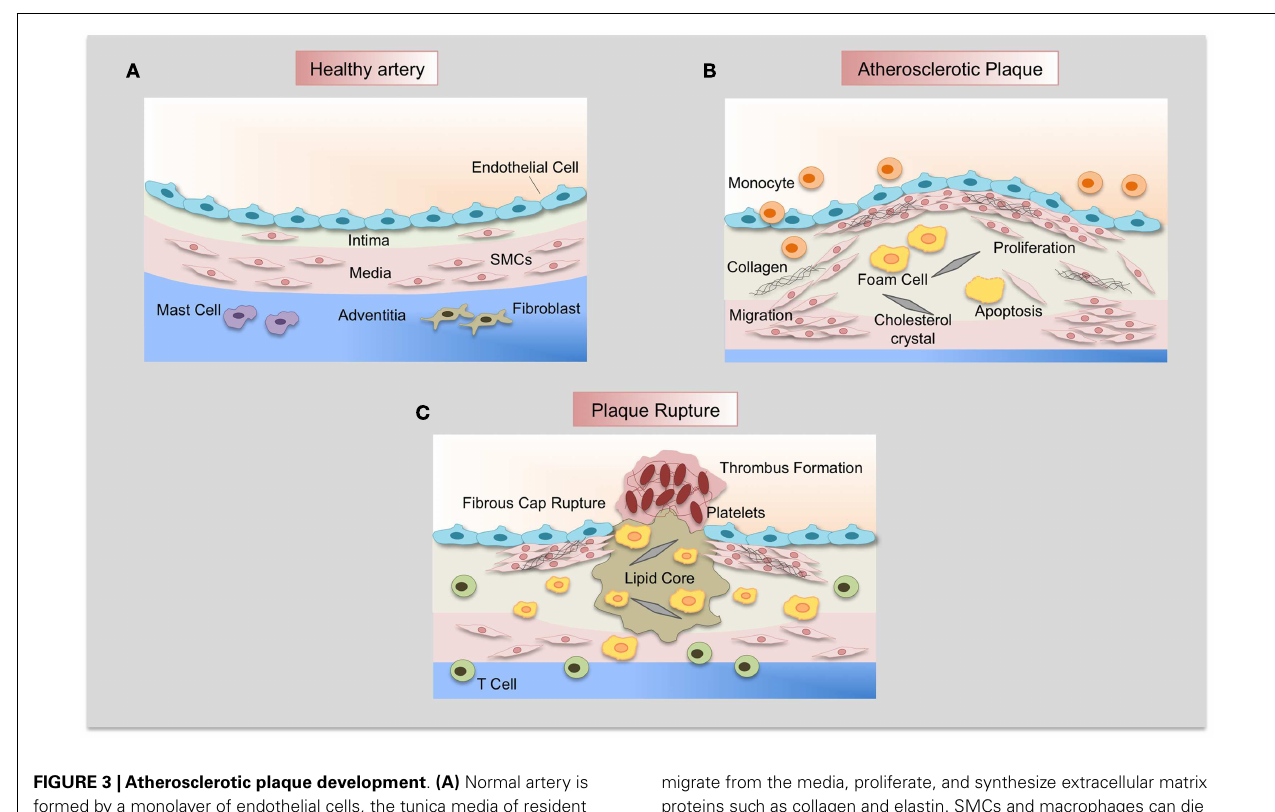
FIGURE 3 |Atherosclerotic plaque development . (A) Normal artery is formed by a monolayer of endothelial cells, the tunica media of resident smooth muscle cells embedded in an extracellular matrix, and the adventitia that contains mast cells, fibroblasts, and microvessels. (B) Adhesion of leukocytes to dysfunctional endothelium leads to their migration into the vascular wall, forming the neointima. Monocytes differentiate to macrophages and uptake lipids yielding foam cells. SMCs